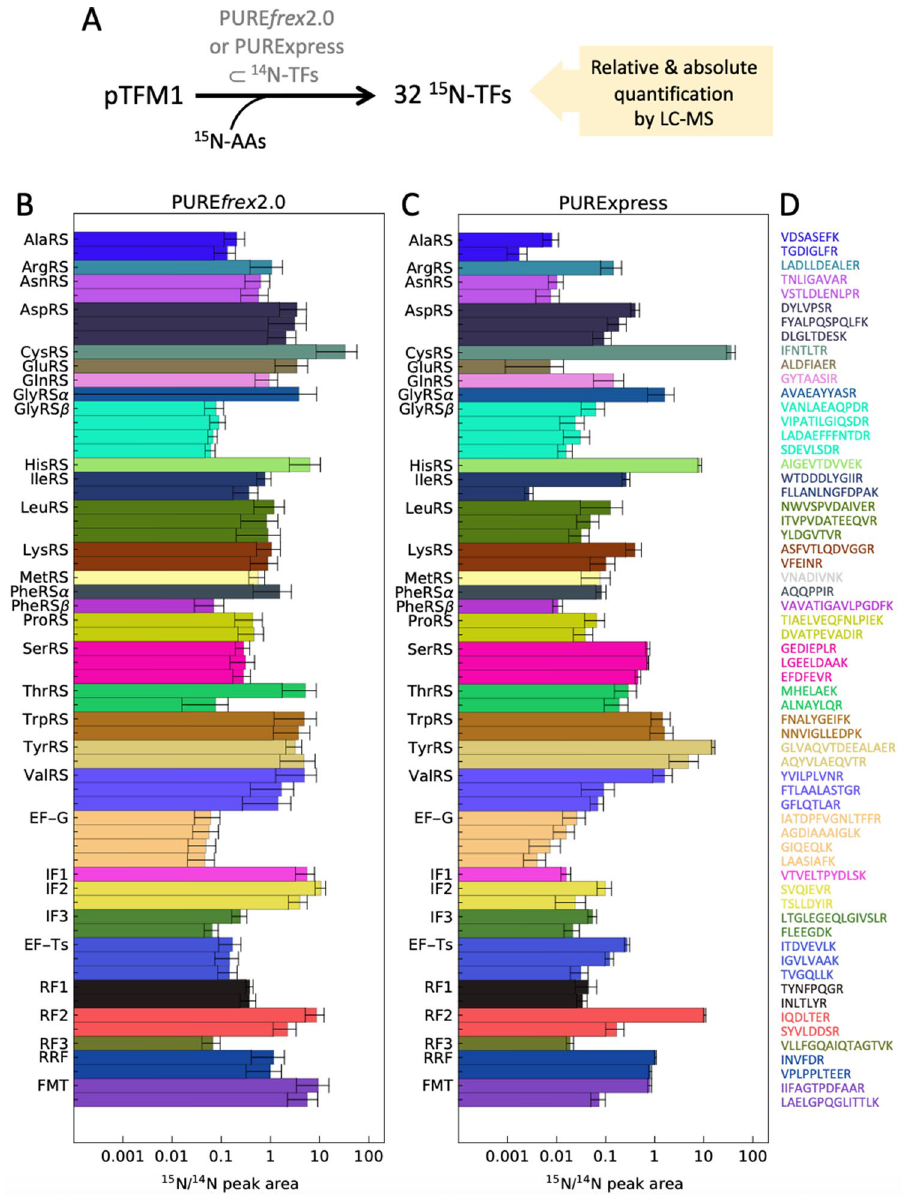
Figure 2. In vitro production of 32 translation factor proteins from a single plasmid. ( A ) Reaction scheme for pTFM1 expression in the PURE system. AAs amino acids, TFs translation factors, FMT methionyl-tRNA- formyltransferase, IF initiation factor, EF elongation factor, RF release factor, RRF ribosome recycling factor. ( B , C ) Relative expression levels of proteins expressed from pTFM1 with PURE frex 2.0 ( B ) and PURExpress ( C ) after 5 h incubation at 37 °C. Ratios of 15 N-labeled peptides (newly synthesized proteins) to 14 N peptides (original proteins) are displayed for all measured peptides; for proteins with multiple measured peptides, the peptides are ordered from N- to C-terminus (top to bottom). Error bars denote ± 1 standard deviation from triplicate experiments. Results from a different batch of PURE frex 2.0 are shown in Supplementary Fig. 2. ( D ) Specific peptides measured in ( B ) and ( C